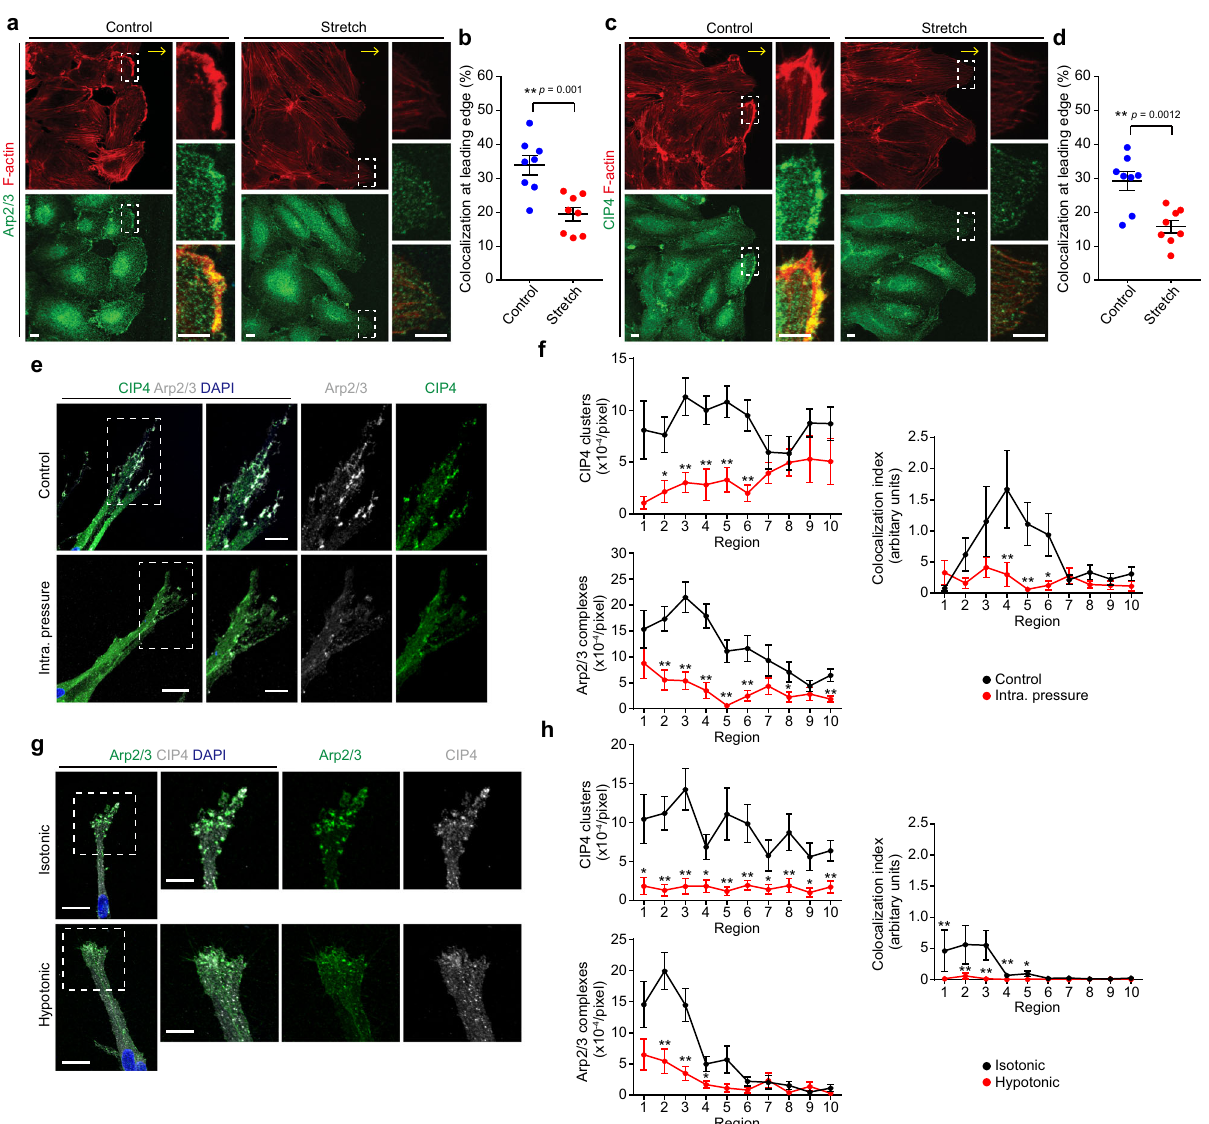
Fig. 8 IP load-induced EC stretching causes detachment of CIP4 and TOCA1 from the leading edge of ECs to inhibit branch elongation. a – d Effects of biaxial stretching on colocalization of Arp2/3 complexes ( a , b ) and CIP4 ( c , d ) with F-actin at leading edges of HUVECs directionally migrating on stretching chambers. Confocal fl uorescence images of HUVECs exposed to continuous biaxial stretch for 3 min after being stretched to 10% over 8 min (Stretch) or kept under static conditions (Control). Left upper, F-actin (red); left lower, ARPC2 (Arp2/3, green) ( a ) or CIP4 (green) ( c ). F-actin (upper), ARPC2 or CIP4 (middle), and merged (lower) images of boxed areas are enlarged on the right. In a , c , yellow arrows indicate the direction of cell migration. b , d Quanti fi cation of Arp2/3 complexes ( b ) and CIP4 ( d ) colocalized with F-actin at leading edges of HUVECs, as in a , c , respectively. Each dot represents an individual confocal image (blue, Control; red Stretch). Data are means ± s.e.m ( n = 8 regions examined over 2 independent experiments for each). ** p < 0.01 by two-sided t test. e , f Effects of IP loading on localization of CIP4 and Arp2/3 complexes at the leading edge of on-chip angiogenic branch. e Confocal z -projection images of angiogenic sprouts loaded without (upper) and with IP (lower) for 20 min. Boxed areas are enlarged on the right. Green, CIP4; gray, ARPC2 (Arp2/3); blue, DAPI. f Quanti fi cation of the number of CIP4 clusters (upper left), that of Arp2/3 complexes (lower left), and the degree of their colocalization (right) in individual regions of angiogenic branches, as in e . The number of CIP4 clusters and that of Arp2/3 complexes are shown as in Fig. 4d – f. The colocalization index of CIP4 clusters and Arp2/3 complexes is given as described in “ Methods. ” Data are means ± s.e.m (Control and IP, n = 23 and 19 branches examined over 3 independent experiments). * p < 0.05, ** p < 0.01 versus Control. g , h Effects of hypotonic stimulation on localization of CIP4 and Arp2/3 complexes at the leading edge of an on-chip angiogenic branch. g Confocal z -projection images of angiogenic sprouts treated with isotonic medium (upper) and hypotonic medium (lower) for 5 min are as in e . h Quantitative data of g are as in f . Data are means ± s.e.m. (Isotonic and Hypotonic, n = 20 and 22 branches examined over 3 independent experiments). * p < 0.05, ** p < 0.01 versus Control. Statistical signi fi cance was determined by two-sided Mann – Whitney U test ( f , h ). For detailed statistics in f , h , see Supplementary Table 4. Source data are provided as a Source data fi